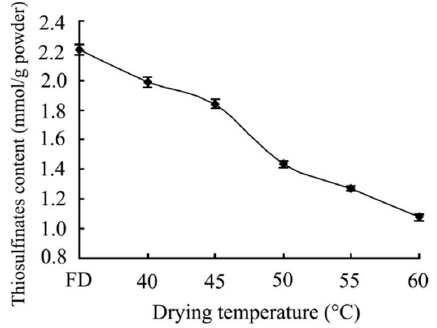
Figure 1. Effect of drying temperature on thiosulfinate content in garlic powder. FD (Freeze dried garlic powder).